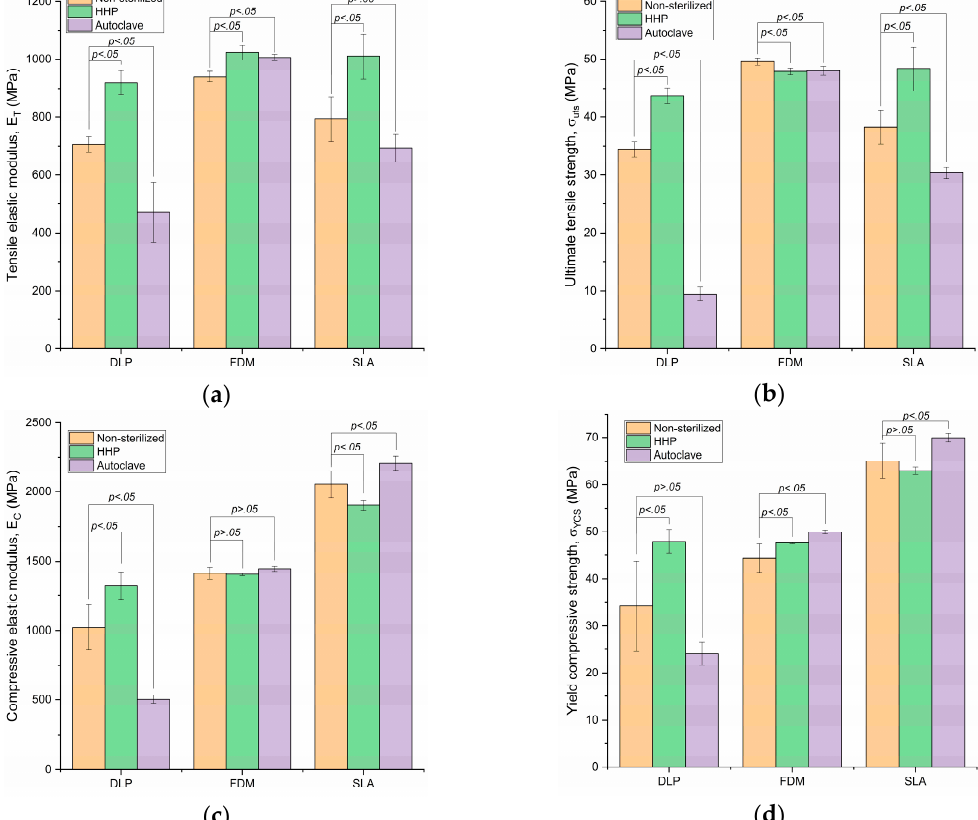
Figure 4. Mechanical properties obtained from the tests for DLP, FDM, and SLA. Mean values, standard deviations, and p -values are shown for: ( a ) Tensile elastic modulus ( E T ); ( b ) ultimate tensile strength ( σ uts ); ( c ) compressive elastic modulus and ( E C ); and ( d ) yield compressive strength ( σ YCS ).